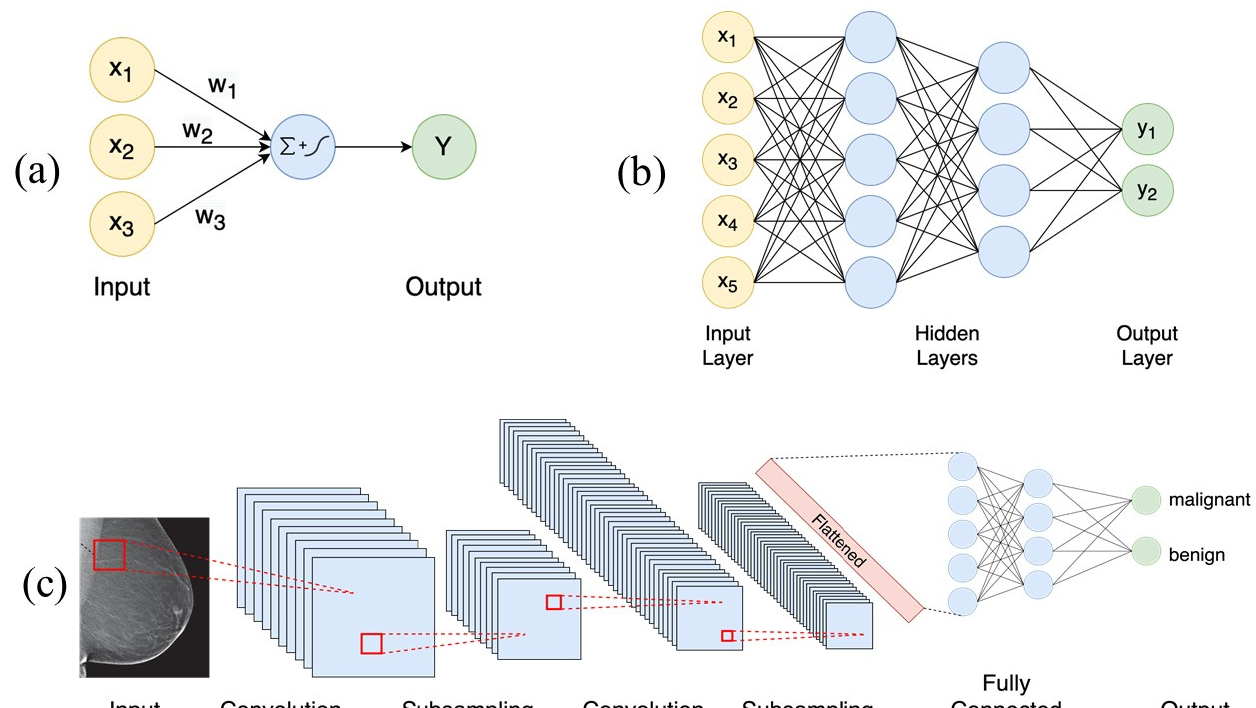
Figure 1. ( a ): Neuron, the fundamental computational unit of a neural network, computes the weighted sum of its inputs (X 1 , X 2 , X 3 ) and applies a non ‐ linear operation to give output (Y). ( b ): An example of a feedforward neural network with two hidden layers, with five and four neurons, re ‐ spectively. ( c ): An example of a convolutional neural network (CNN) applied to the classification of a screening mammogram as probable malignant or benign.